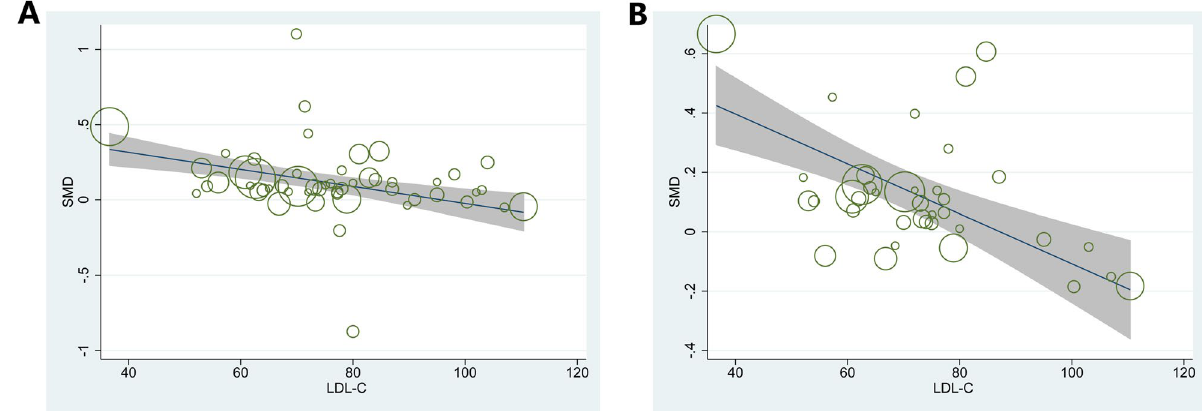
Figure 4. Meta–regression analyses for SMD in plaque volume between patients at baseline and follow-up: ( A ) effect of LDL on TAV; ( B ) effect of LDL on